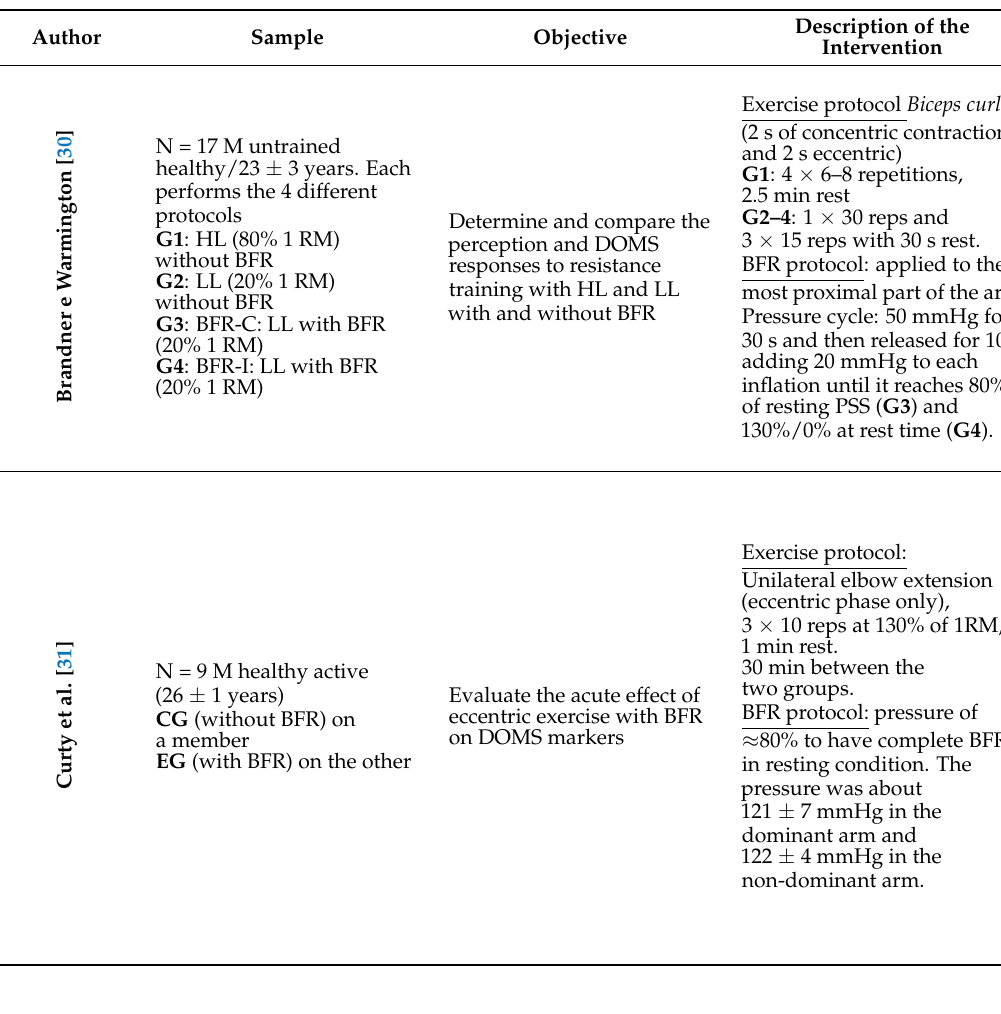
Table 2. Sample description table, objectives, intervention, outcomes, results, and conclusion of the 8 studies included in the systematic